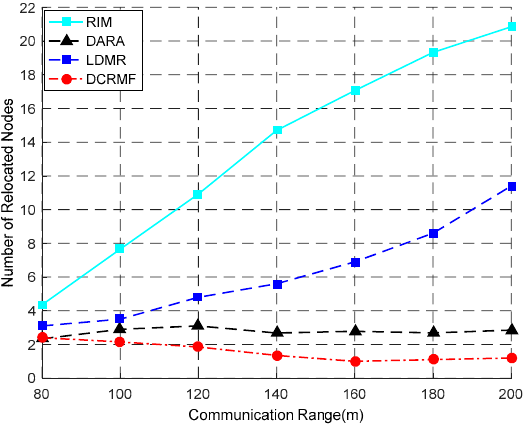
Figure 12. The relationship between the number of relocated nodes and the communication range by using the four algorithms.